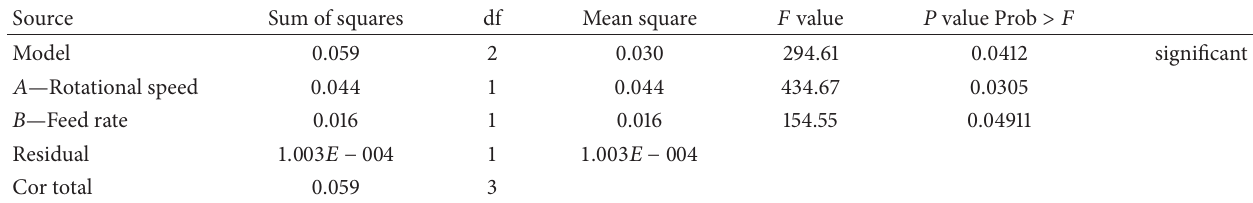
Table 4: Analysis of variance (ANOVA) for the selected factorial model.